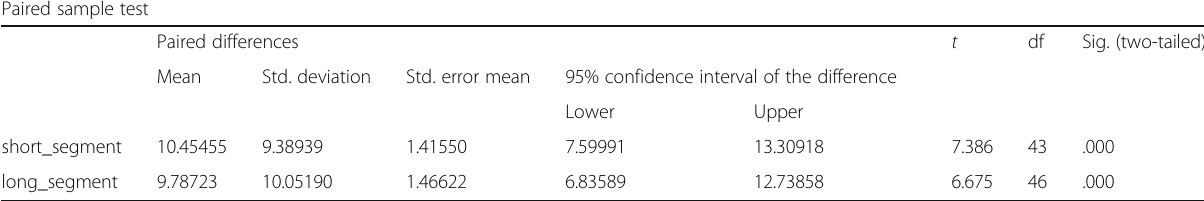
Table 4 The changes in the ODI at the 12th month evaluation visit Paired sample test Paired